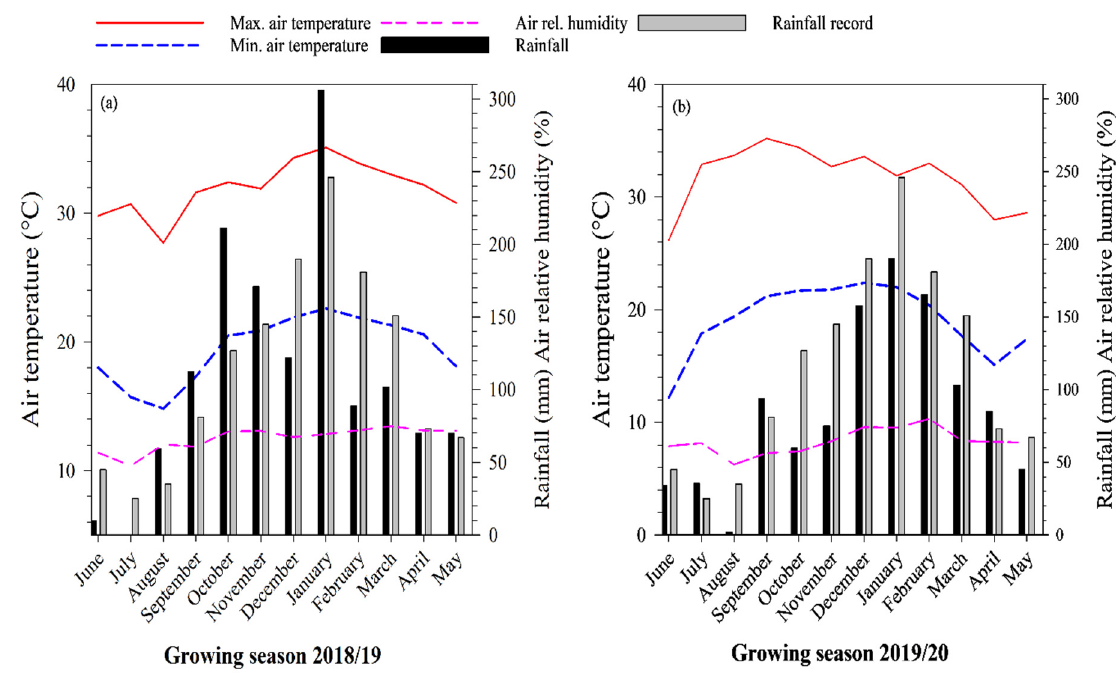
Figure 2. Weather conditions in the growing seasons 2018/19 ( a ) and 2019/20 ( b